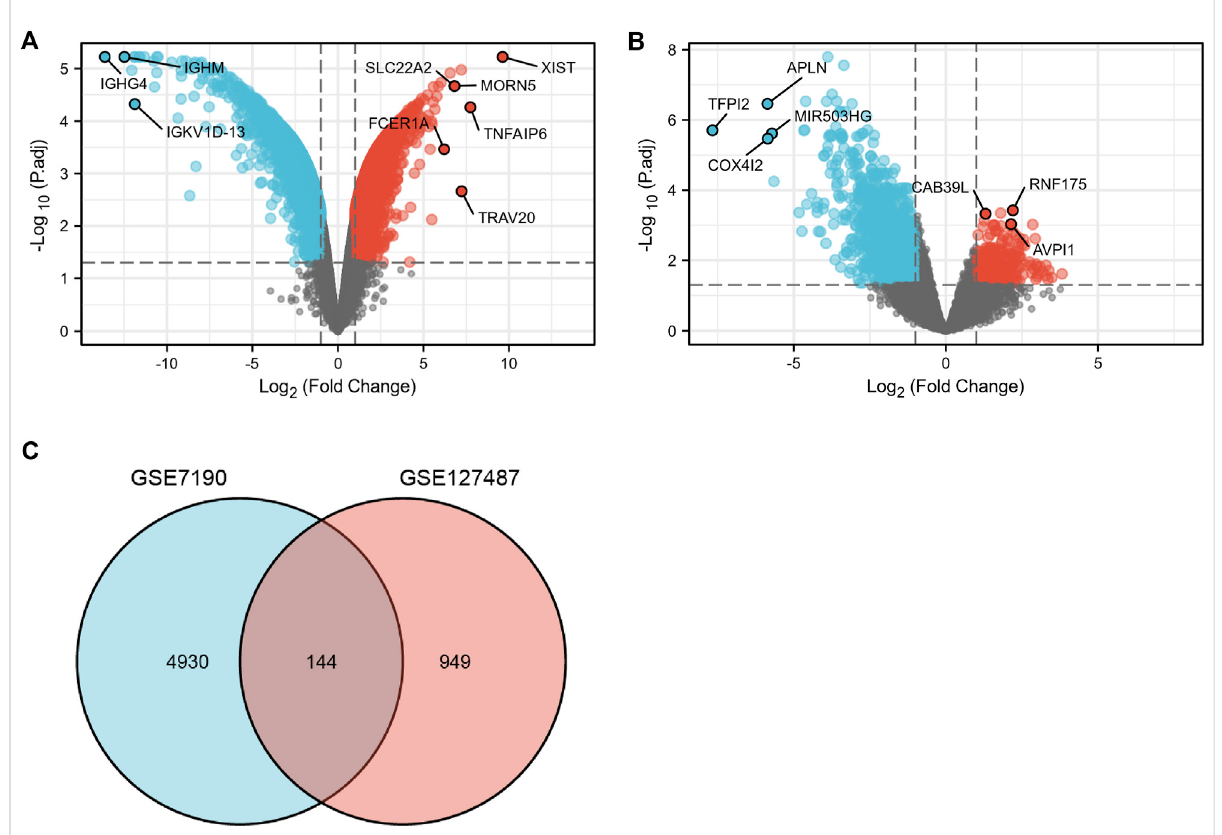
FIGURE 2 The volcano and Venn diagram. (A) , the volcano diagram of GSE7190. (B) , The volcano diagram of GSE127487. (C) , Venn diagram showed an overlap of 144 common